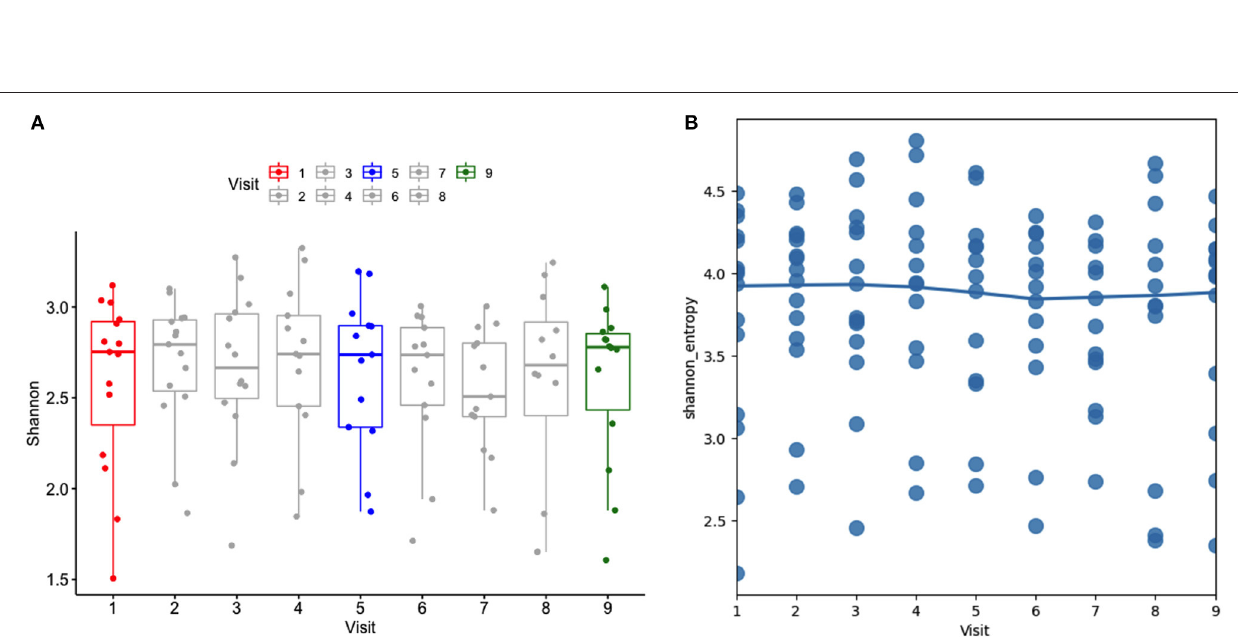
Frontiers in Veterinary Science |